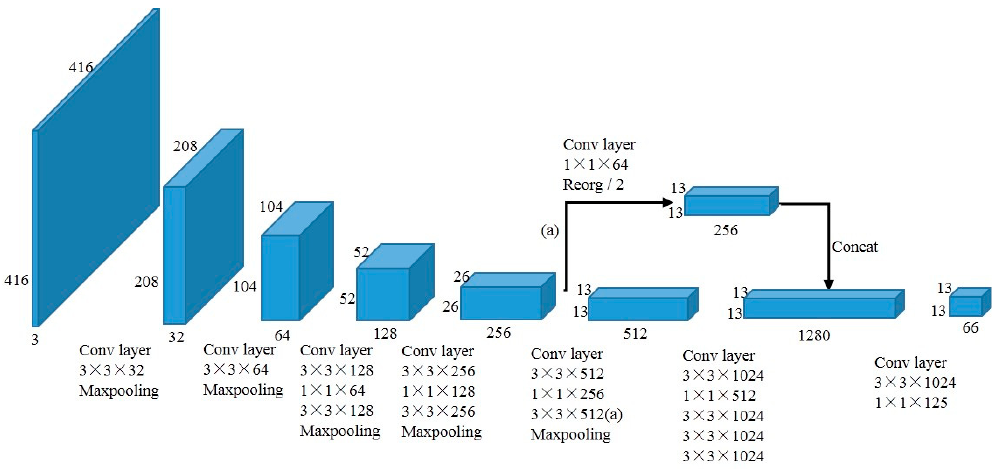
Figure 1. The network of YOLOv2.